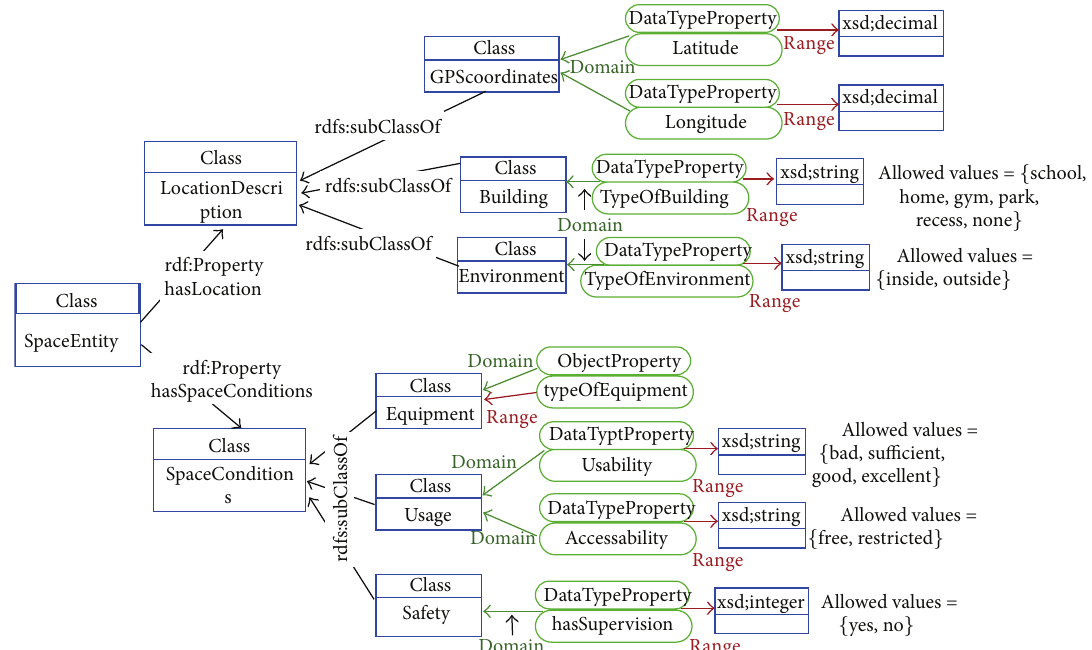
Figure 5: Conceptual diagram of information to characterize the space where the physical activity takes